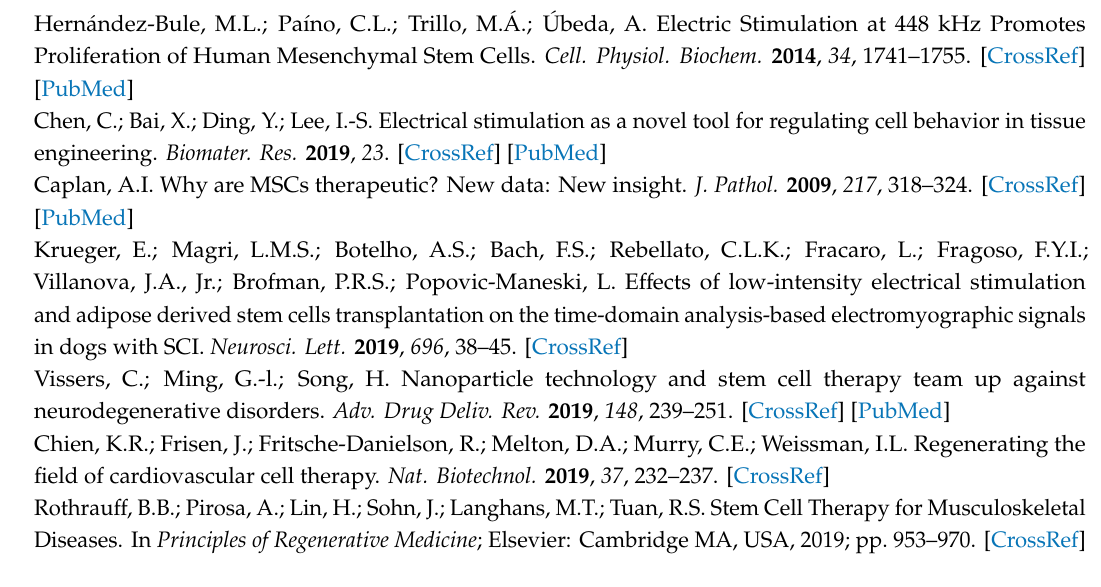
Supplementary Figure S1: Surface marker expression in human adipose-derived mesenchymal stem cells (hADSC) detected by flow cytometry. (A) Representative illustration of a flow cytometric analysis of ADSC at passage 8 using mesenchymal and hematopoietic stem cell markers. Singlets (dot plot side scatter width (SSC-W) versus side scatter height (SSC-H) from mononuclear cells (MNCs, plot SSC-area (A) versus forward scatter FSC-A) and negative-expressing cells for 7-AAD were included for further analysis. Mesenchymal stem cell markers (CD105, CD13, CD90, CD73) were present whereas hematopoietic stem cell markers (CD34, CD45) as well as bone marrow specific antigen CD36 were hardly to detect. (B) Means of percentages of the corresponding CD’s of viable singlets. n = 3 (ADSC were taken from passages 8 ( n = 2) and 9 ( n = 1)), Supplementary Table S1: List of antibodies / dyes used for flow cytometric